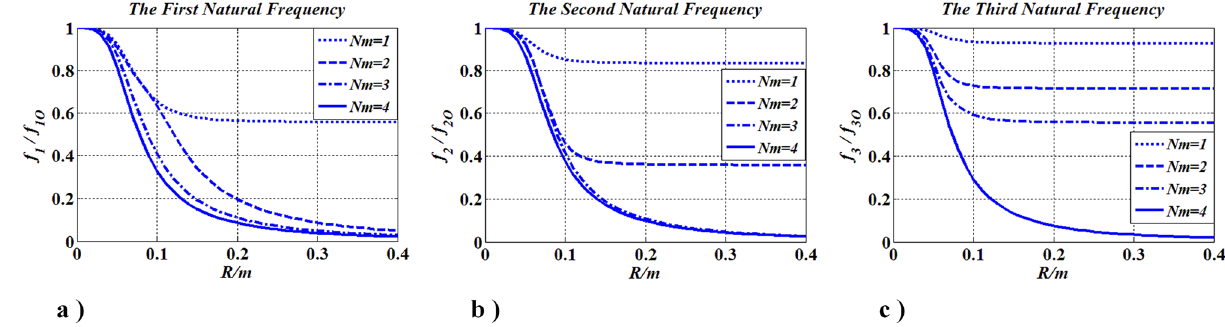
Figure 18. Frequencies change with R ( J m ) and N m .